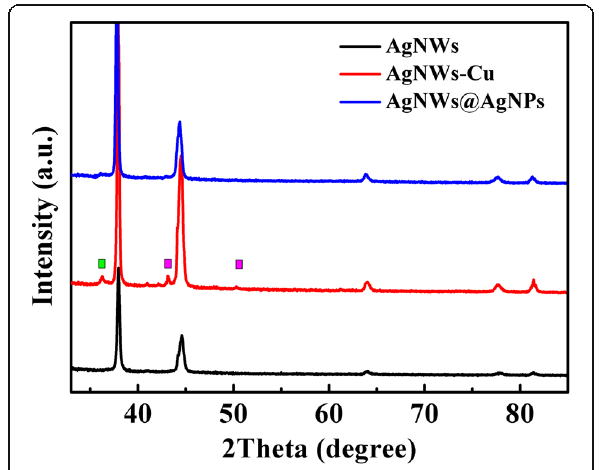
Fig. 3 XRD pattern of the aligned AgNWs, Cu-decorated aligned AgNWs film, and AgNWs@AgNPs film